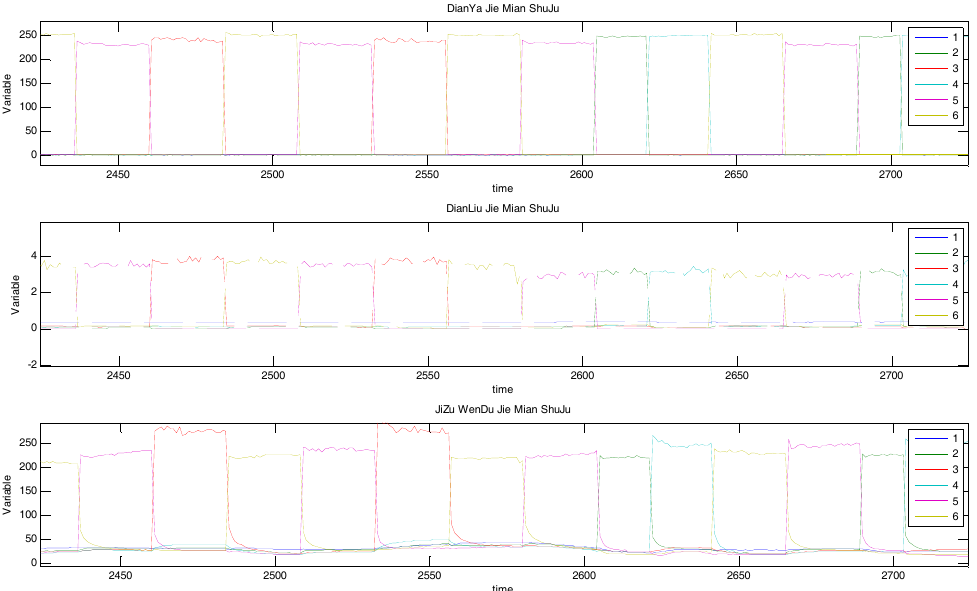
Figure 5. (2011.02.20~2011.02.26) Engines working curves of output voltage, current, and exhaust temperature. Icons are similar to Figure 4, but in abscissa 2600 or so (denotes 2011.02.24), engine working priority was remotely adjusted.